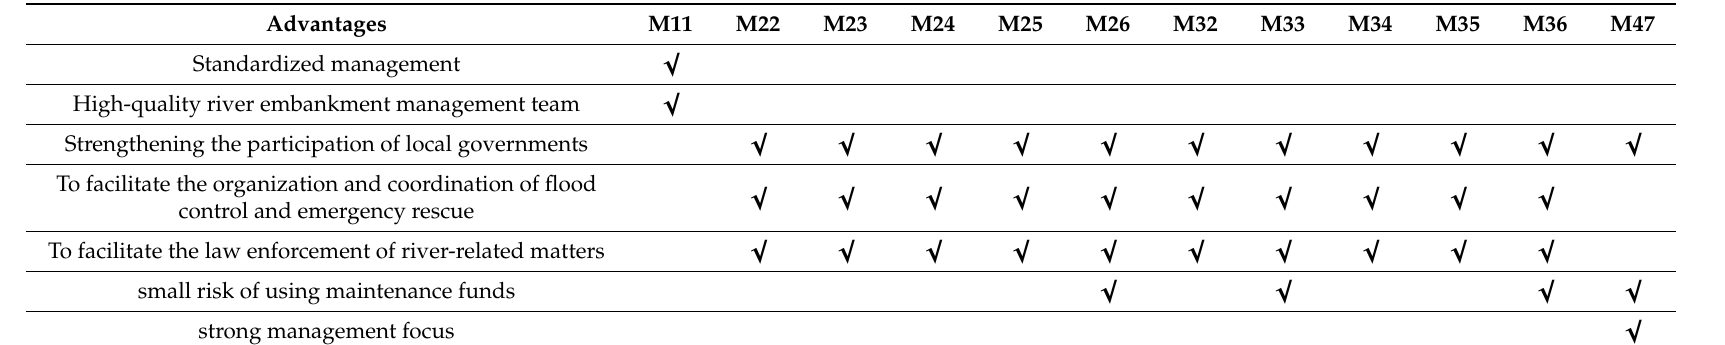
Table A2. Comparisons of river operation management modes’